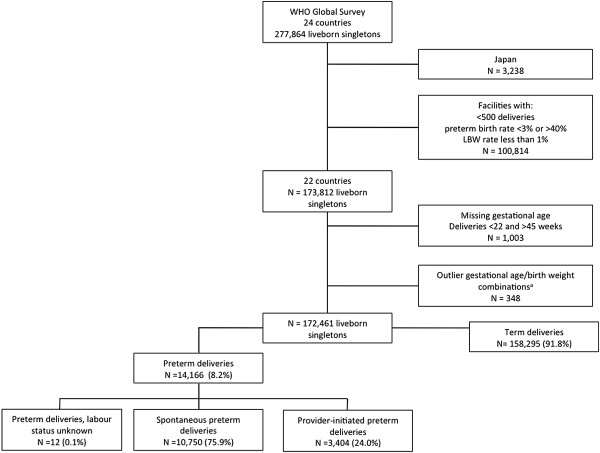
Study flowchart.